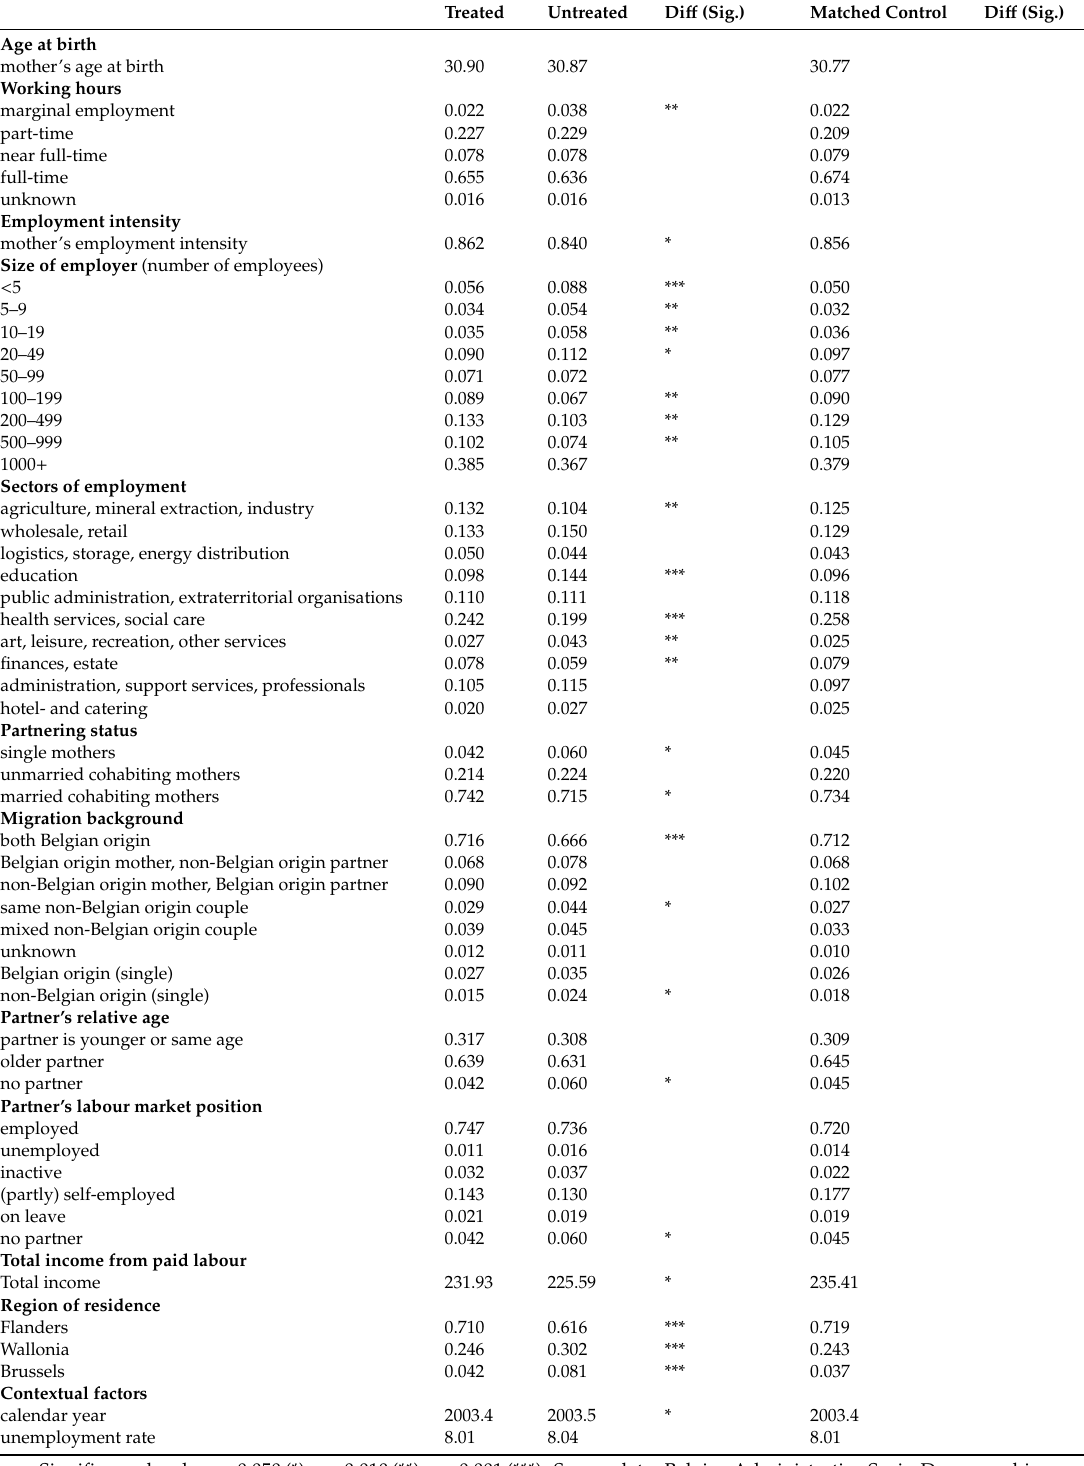
Table 2. Sample characteristics (means and proportions) for 3143 women who experienced a second birth in 2001–2005, Belgium. Treated Untreated Di ff (Sig.) Di ff